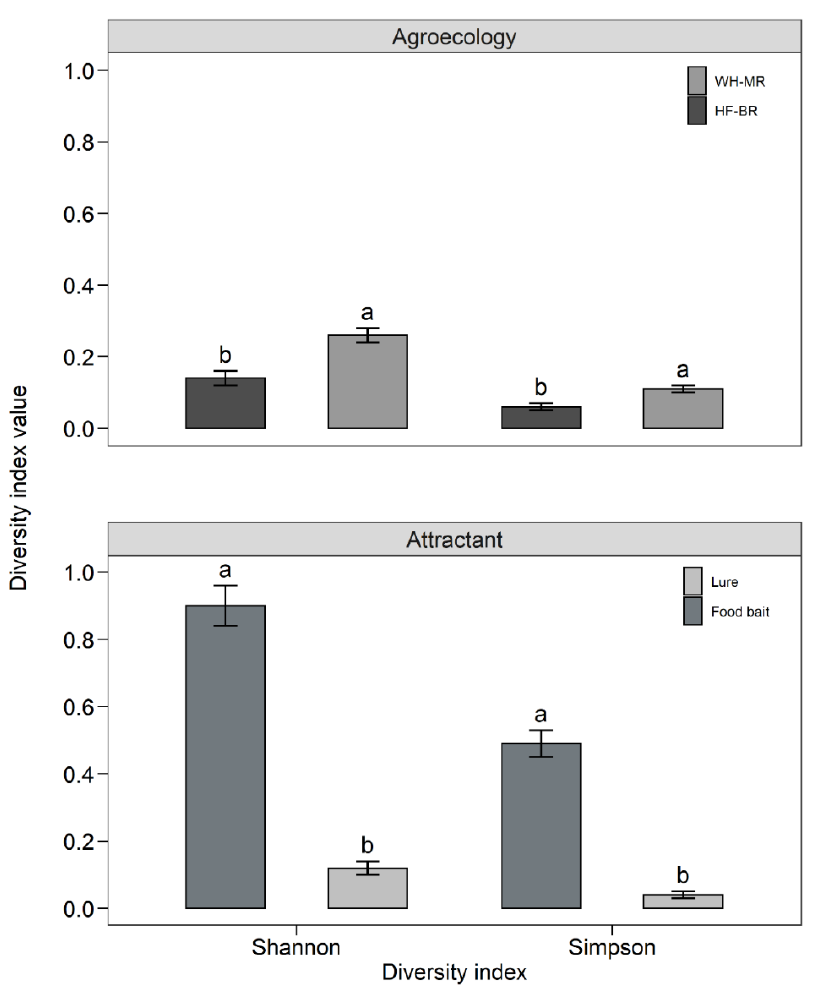
Figure 2. Shannon and Simpson indices (means ± SE) of fruit fly diversity according to agro-ecological zones and attractants. Means (vertical bars) followed by the same letter on each index are not significantly different (Kruskal – Wallis test , p < 0.05 ).